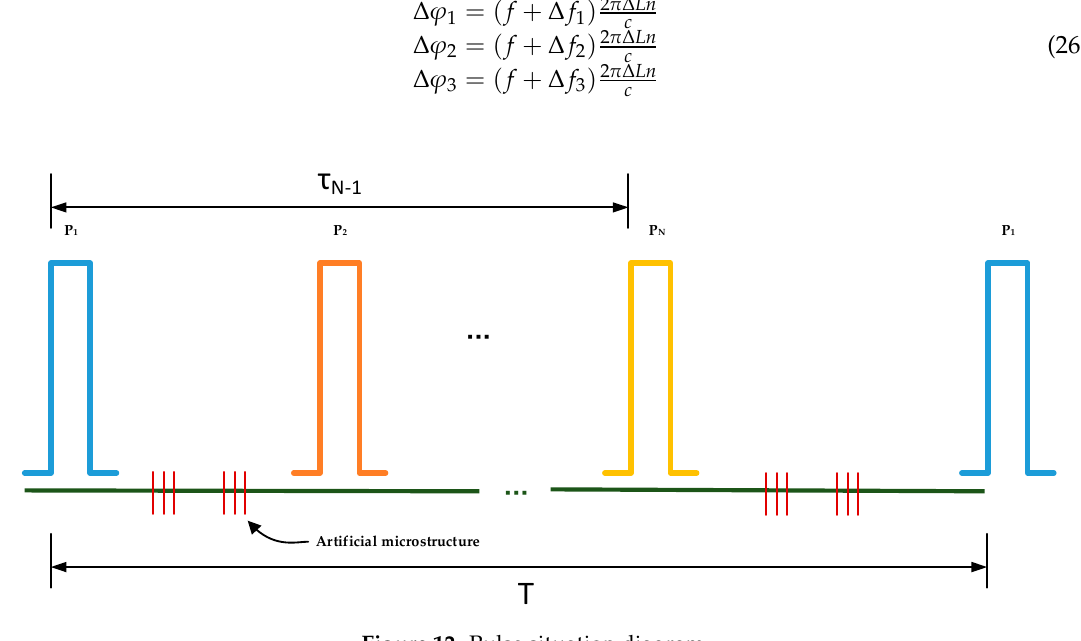
Figure 12. Pulse situation Figure 12 Pulse situation diagram.